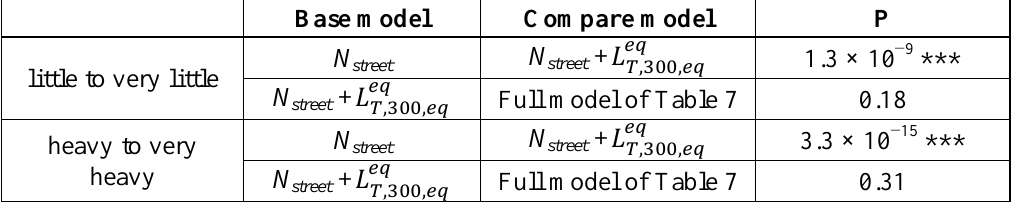
Table 9. p value in ANOVA chi squared test comparing different models for predicting reported traffic intensity in the neighborhood (Q1.8).